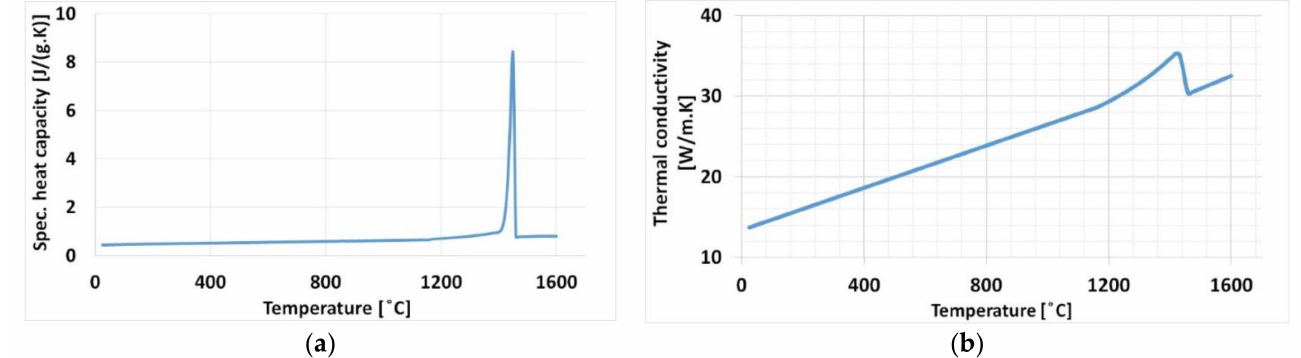
Figure 4. Temperature-dependent material properties ( a ) Specific heat capacity ( b ) Thermal conduc- tivity [10].